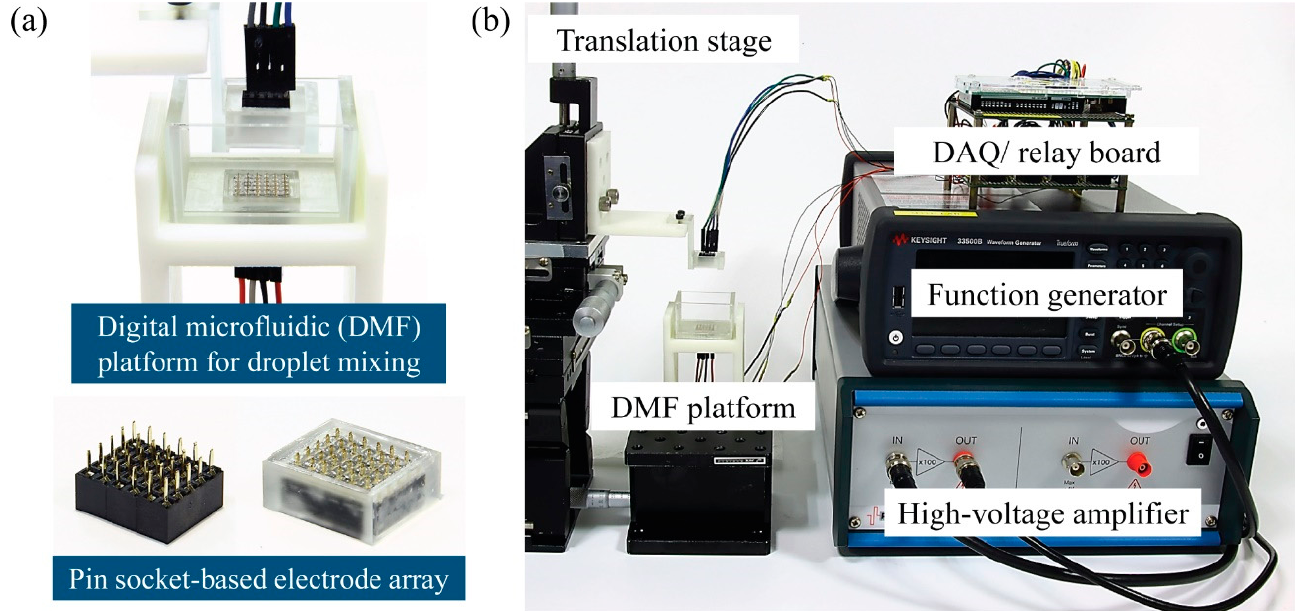
Figure 2. ( a ) Schematic of the digital microfluidic (DMF) platform for droplet mixing using reciprocating droplet motion driven by contact charge electrophoresis (CCEP). The electrode system of the DMF platform comprises a small commercial pin socket and a 3D-printed enclosure. ( b ) Entire experimental setup for DMF mixing with CCEP actuations.